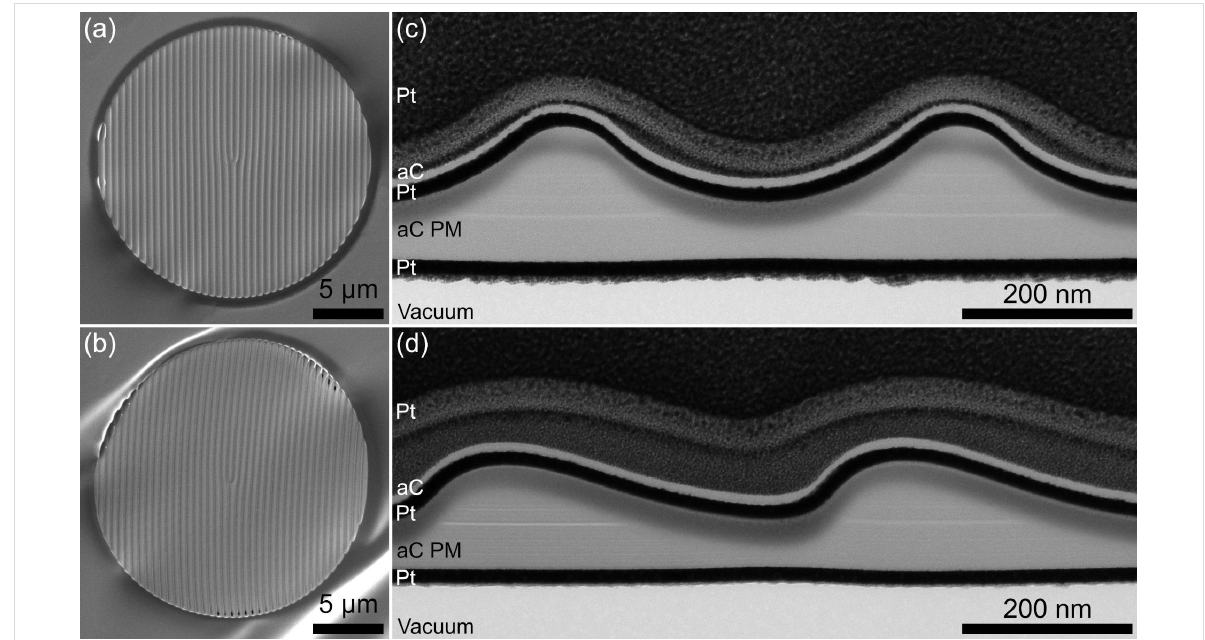
Figure 5: Top-view SEM images of (a) a sinusoidal and (b) a saw-tooth-shaped holographic PM for the generation of VBs. The aC thin films in both images show slight bulging. In (b) holes near the PM edge are visible. Bright-field TEM images of cross-section samples from the (c) sinusoidal and (d) saw-tooth shaped thickness profiles reveal the thickness offset and implanted Ga similar to Figure 4c.